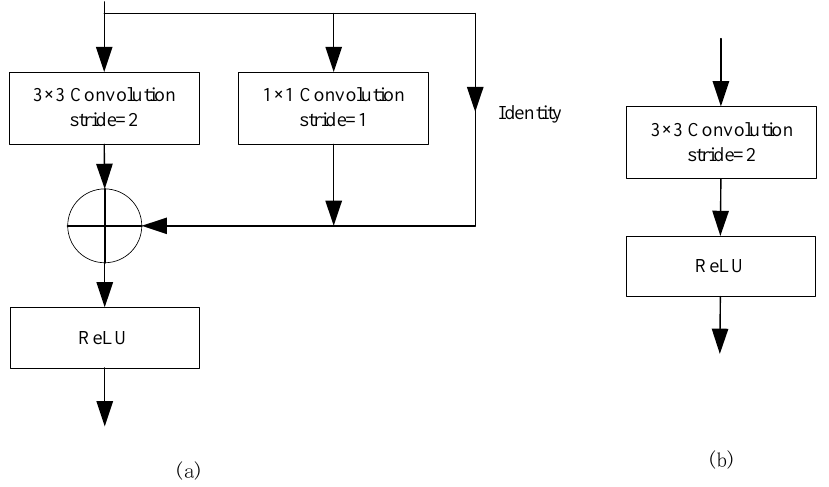
of feature extraction brought by multi branch network training, but also obtain the high speed and low memory consumption of a single path model in inference deployment. The core component of the RepVGG network is the RepVGG Block. Its structure is shown in Figure 3.